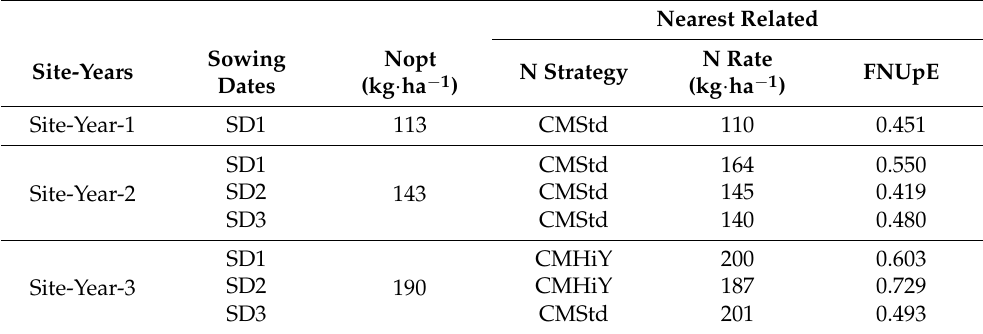
Nearest Related